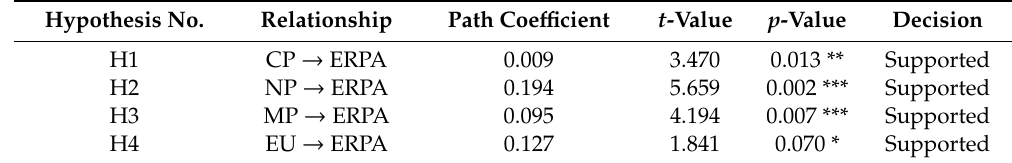
Table 4. Results of the hypothesis testing of the direct association model.